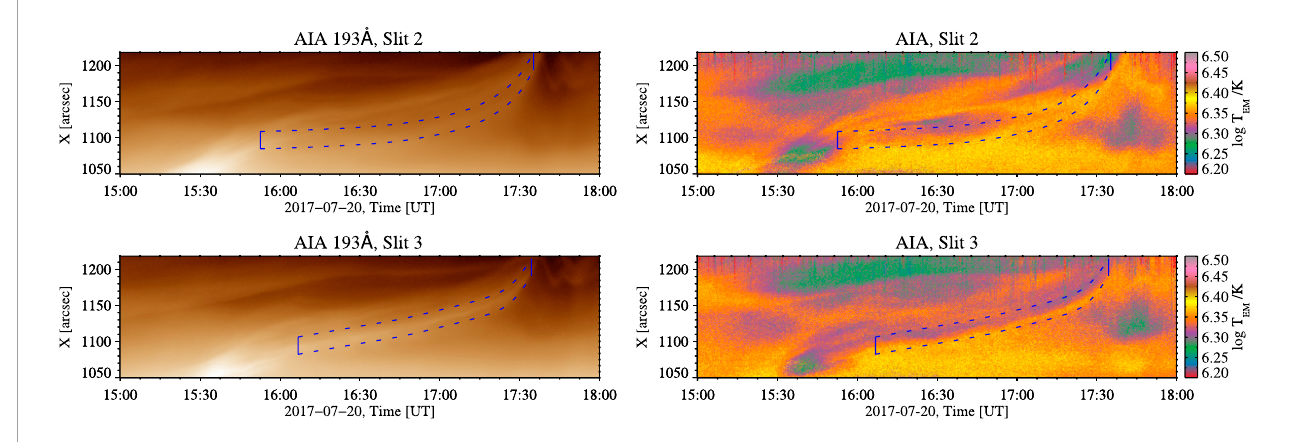
FIGURE 3 The left panel shows AIA 193 Å intensity space-time maps, and the right panel shows the EM-weighted log temperature space-time maps for slit 2 and 3. We visually traced the eruption along each slit intensity space-time map shown by the blue dashed curve in the left panel, which is fitted using the cubic spline interpolation method. The same curve is overplotted over log T EM space-time map of the respective slit.